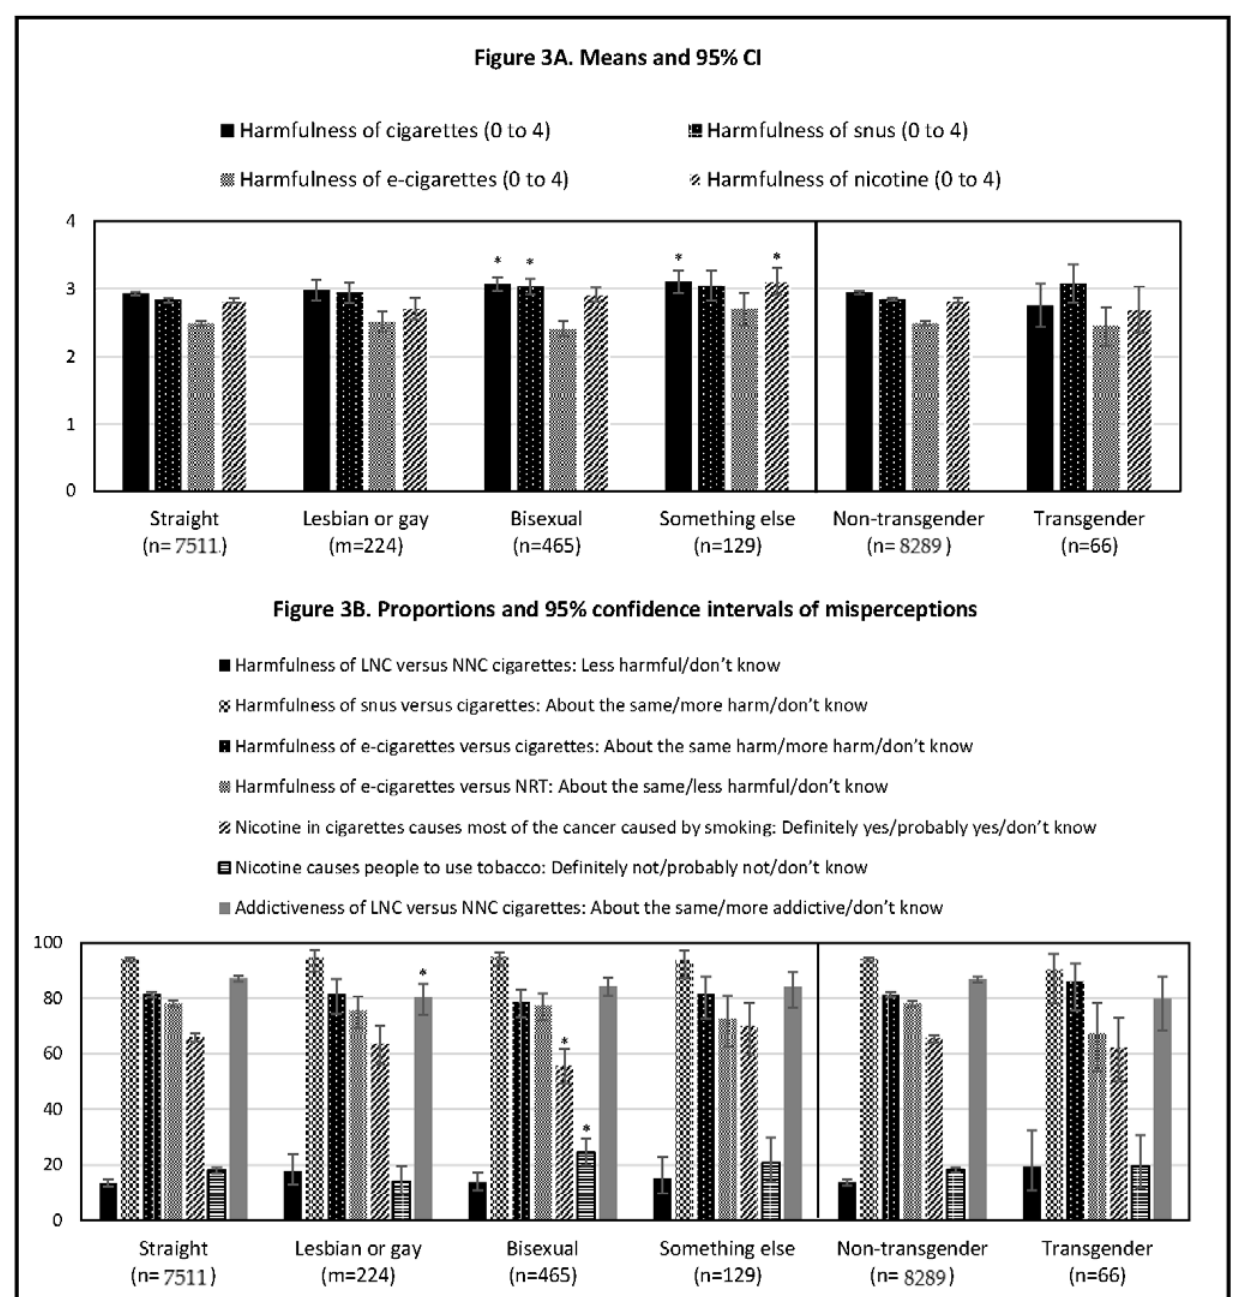
Figure 3. Means or proportions and 95% confidence intervals for response categories. Persons who currently smoke daily or some days by sexual orientation and gender identity. ( A ) displays the perceived harm of products by sexual orientation and gender identity; ( B ) displays the proportion of respondents endorsing a misperception about nicotine or the relative risks of products by sexual orientation and gender identity.